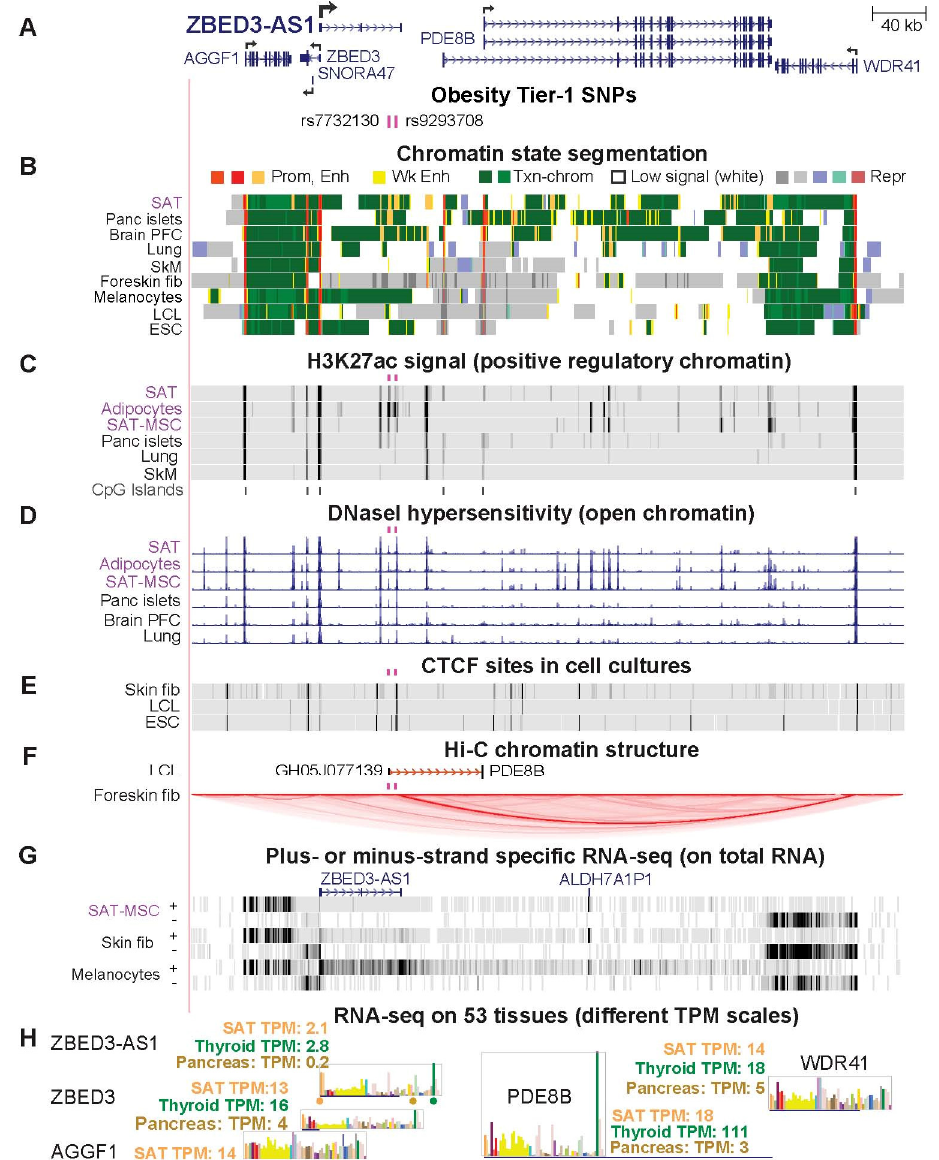
Figure 5. Two Tier-1 SNPs in a lncRNA gene, ZBED3-AS1 , and neighbors ZBED3 , SNORA47 , PDE8B , and WDR41 are near long-distance chromatin looping subregions. ( A ) A 538-kb region (chr5:76,285,728–76,823,921) containing ZBED3-AS1 and neighboring genes; for clarity, additional isoforms of ZBED3 and PDE8B are shown only in Supplementary Figure S14. The main TSS for PDE8B is indicated by a broken arrow. CRHBP , which is referred to in the text but not shown, is 70 kb upstream of AGGF1 . ( B – D ) Chromatin state segmentation, H3K27ac, and DHS as in the previous figures. ( E ) CTCF binding by ChIP-seq profiling of several cell cultures. ( F ) A promoter-capture Hi-C interaction for the lymphoblastoid cell line (LCL) GM12878 and all chromatin interactions in the region detected by Micro-C for foreskin fibroblasts. ( G ) RNA-seq (showing results for transcription from both strands separately) on cell cultures with vertical viewing range 0–30; preadipocytes exhibited no detectable expression of ZBED3-AS1 (not shown); ALDH7A1P1 is a pseudogene. ( H ) Tissue RNA-seq shown as a bar graph with dots color-coded to indicate their position in the bar graph for ZBED3-AS1 . SAT, subcutaneous adipose; panc, pancreatic; PFC, prefrontal cortex; fib, fibroblasts; LCL, lymphoblastoid cell line (GM12878); SAT-MSC, subcutaneous adipose tissue-derived mesenchymal stem/stromal cells; ESC, H1-embryonic stem cells; fib, fibroblasts; TPM, transcripts per million. CpG islands (not shown) overlap all the TSS indicated by broken